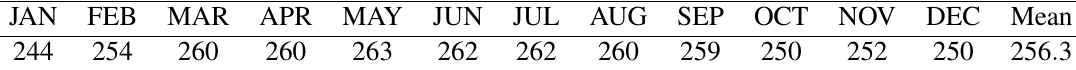
Table 6 Number of certifications per month. Source: own